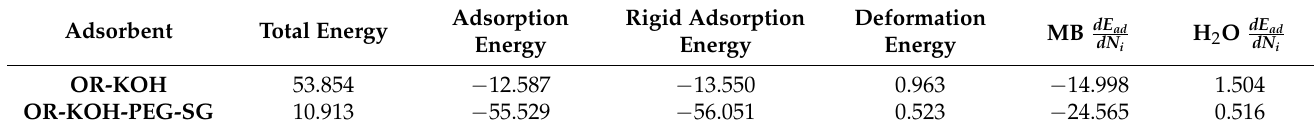
Table 3. Adsorption energies (kcal/mol) of MB in aqueous solution on OR-KOH and OR-KOH/PEG- SG